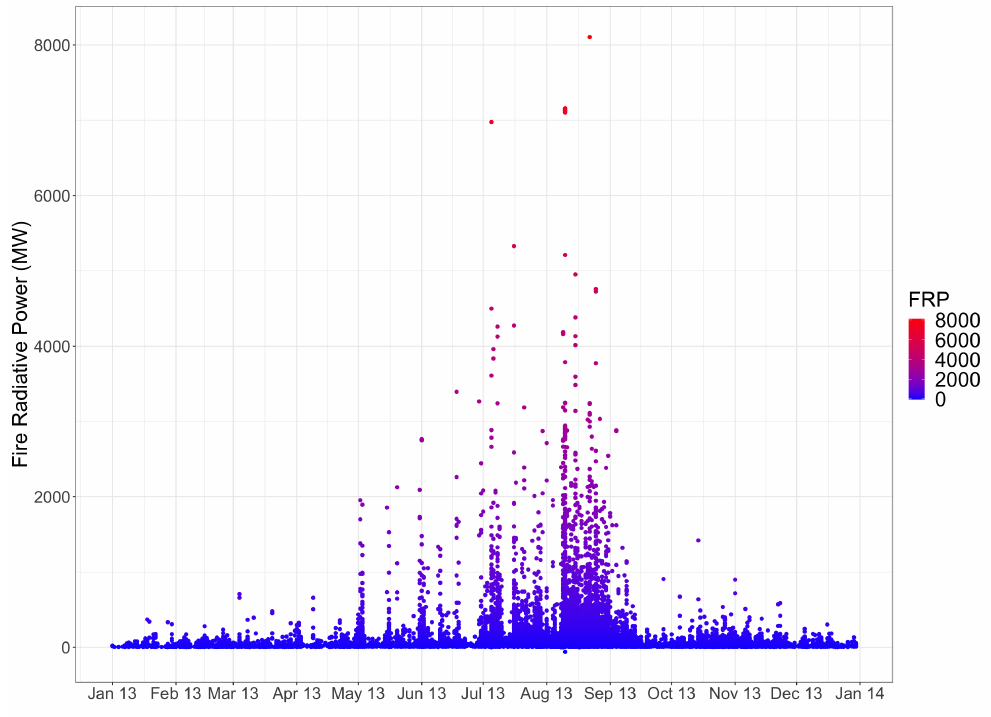
Figure 4. Fire radiative power (FRP) in megawatts from VIIRS. Each point represents the FRP of a single thermal anomaly detected by VIIRS. FRP is related to fire intensity and emissions amount. The VIIRS FRP is not included in any fire emissions inventories and provides an independent dataset for